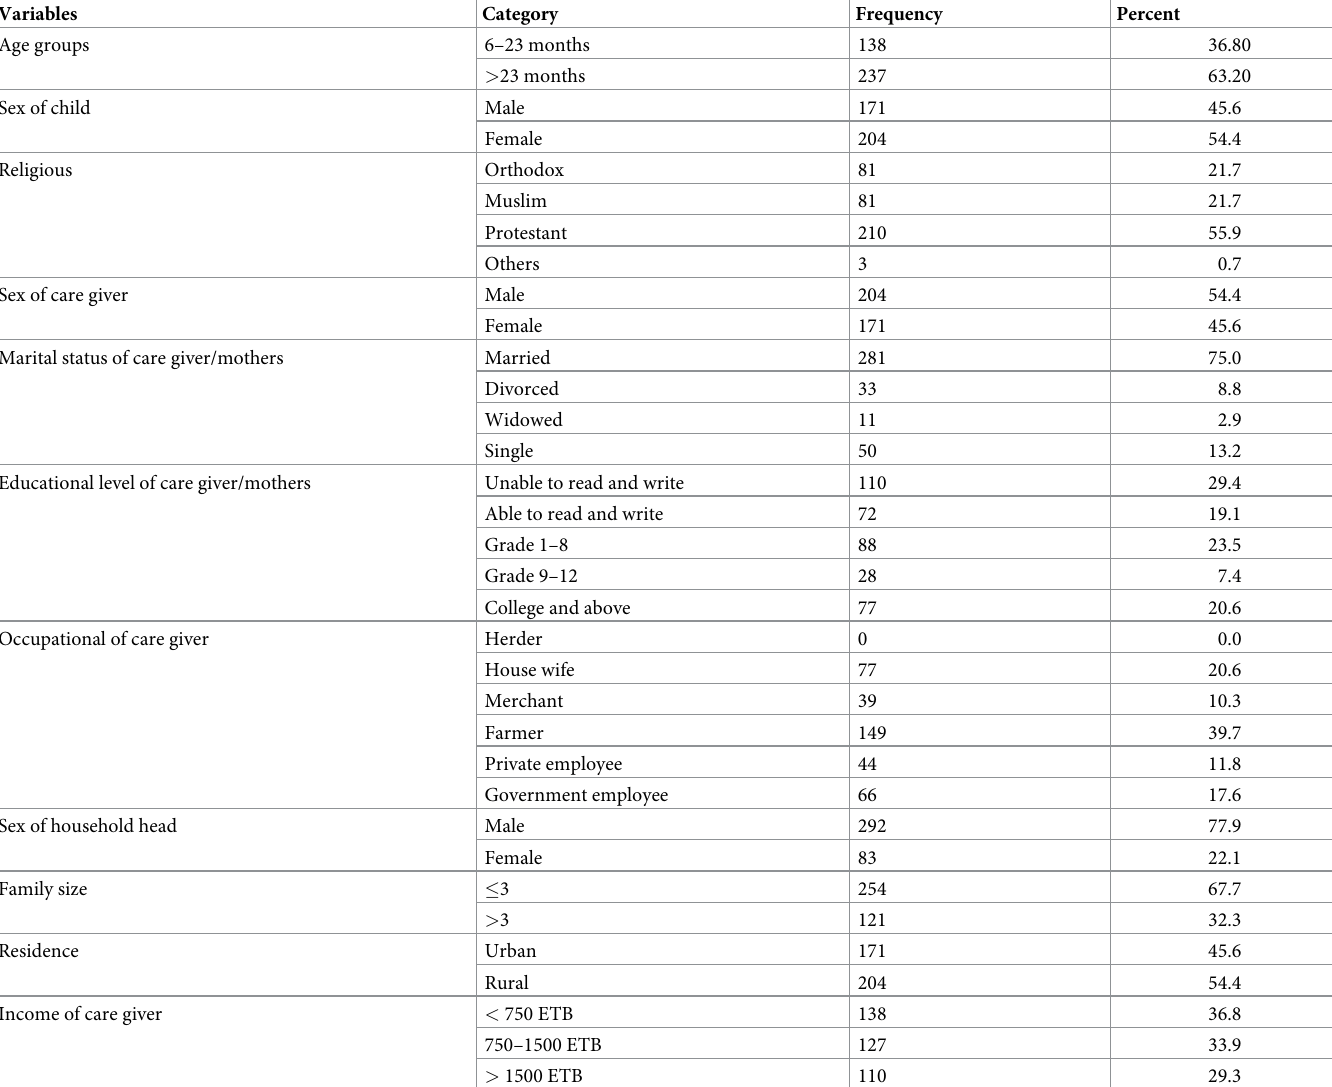
Table 1. Sociodemographic and other selected characteristics of under-five children attending Bule Hora General Hospital, November